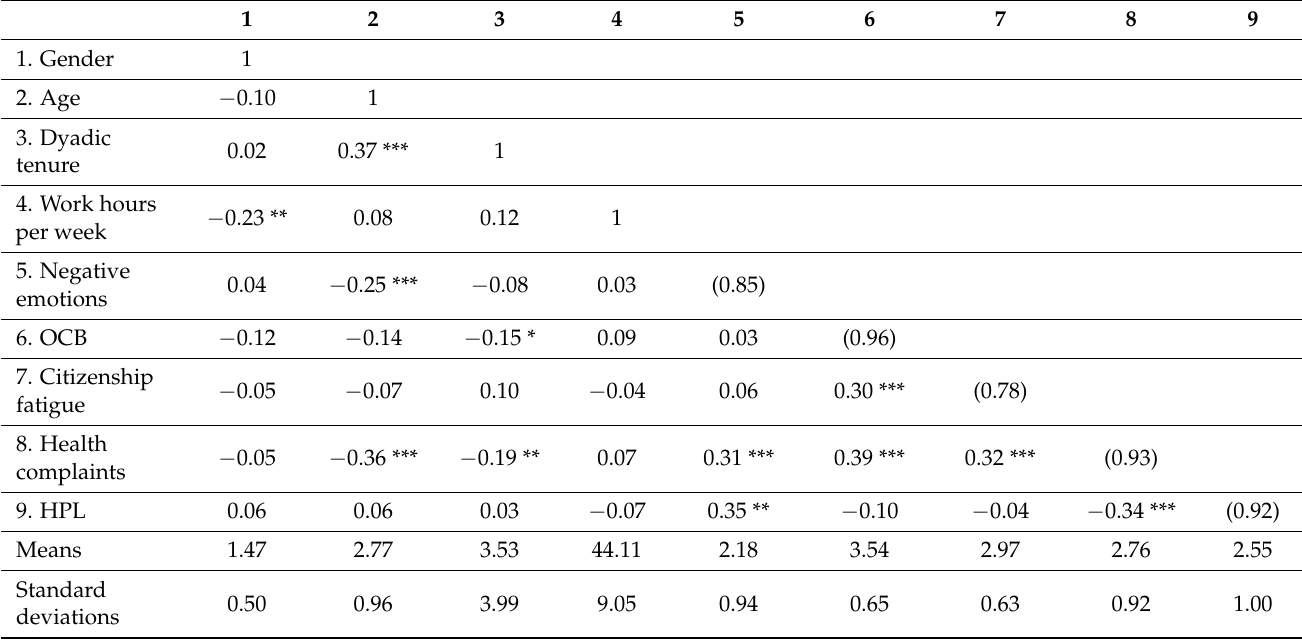
Table 2. Descriptive statistics, alpha coefficients, and correlations ( n = 207).